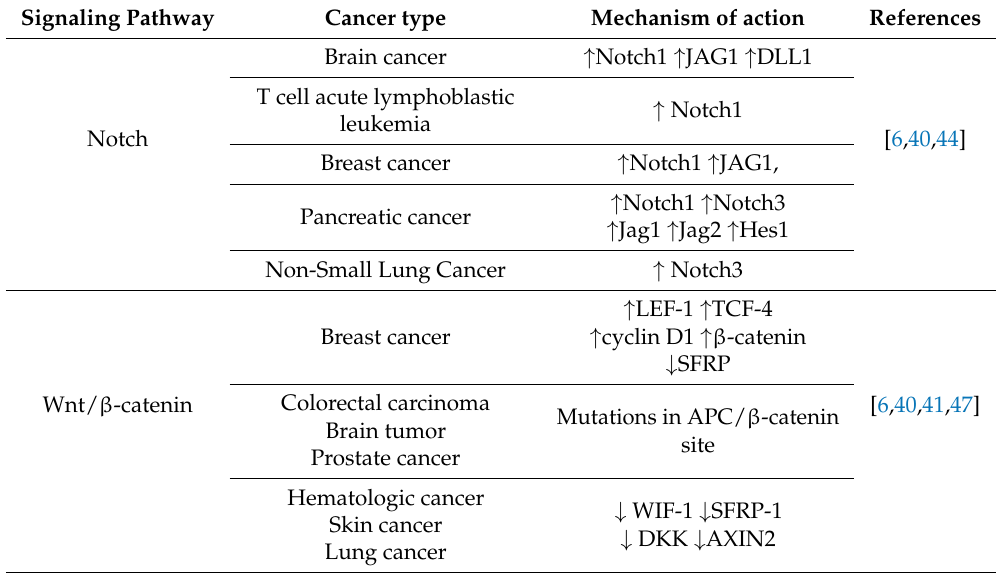
Table 2. Cancer stem cells signaling pathways aberrantly regulated in selected